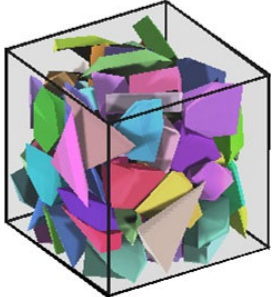
Fig. 19. Best solution obtained of the instance SGPS04 c80 Fig. 20. Best solution obtained of the instance